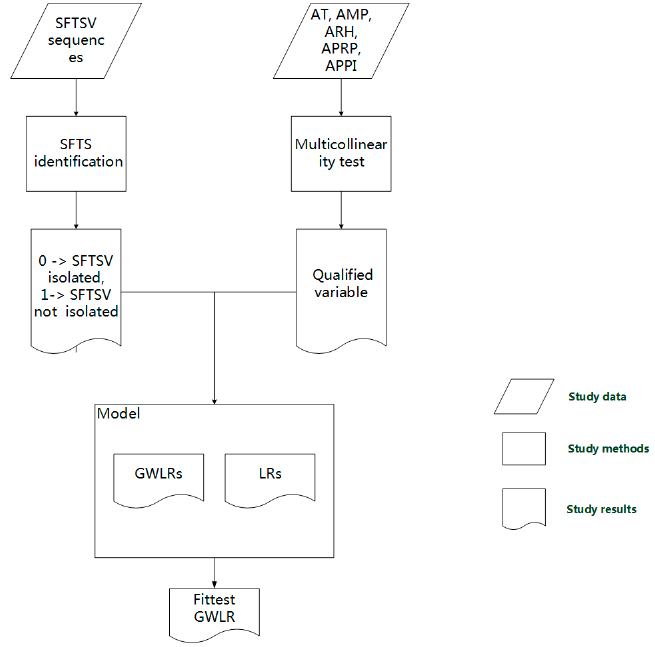
Figure 2. Study flow chart. AMP = average monthly precipitation; APPI = average proportion of primary industries; SFTS = severe fever with thrombocytopenia syndrome; APRP = average proportion of rural population; ARH = average relative humidity; AT = average temperature; GWLR = geographically weighted logistic regression; LR = logistic regression; SFTSV = severe fever with thrombocytopenia syndrome virus.